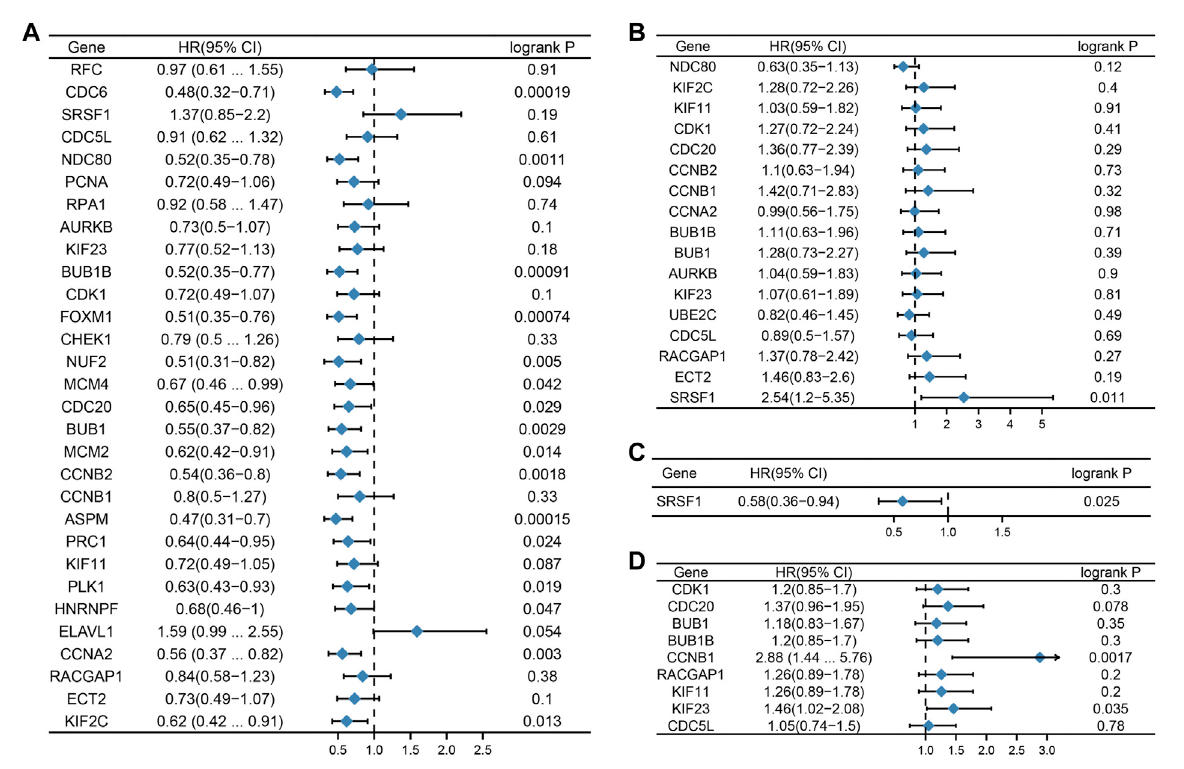
FIGURE 5 Prognostic value of hub genes. Forest plots show the correlation between hub gene expression and prognosis in different subtypes of breast cancer. [ (A) : TNBC, (B) Her2, (C) luminal A, and (D) luminal (B)